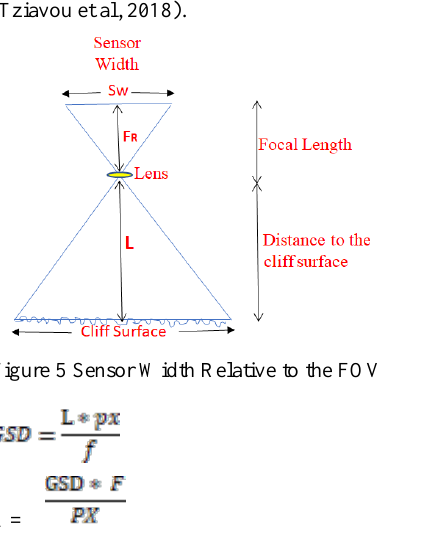
L = (3) Most times the pixels, when projected onto the ground, will not be squared perfectly. The GSD would then be computed for in terms of sensor width and sensor height.